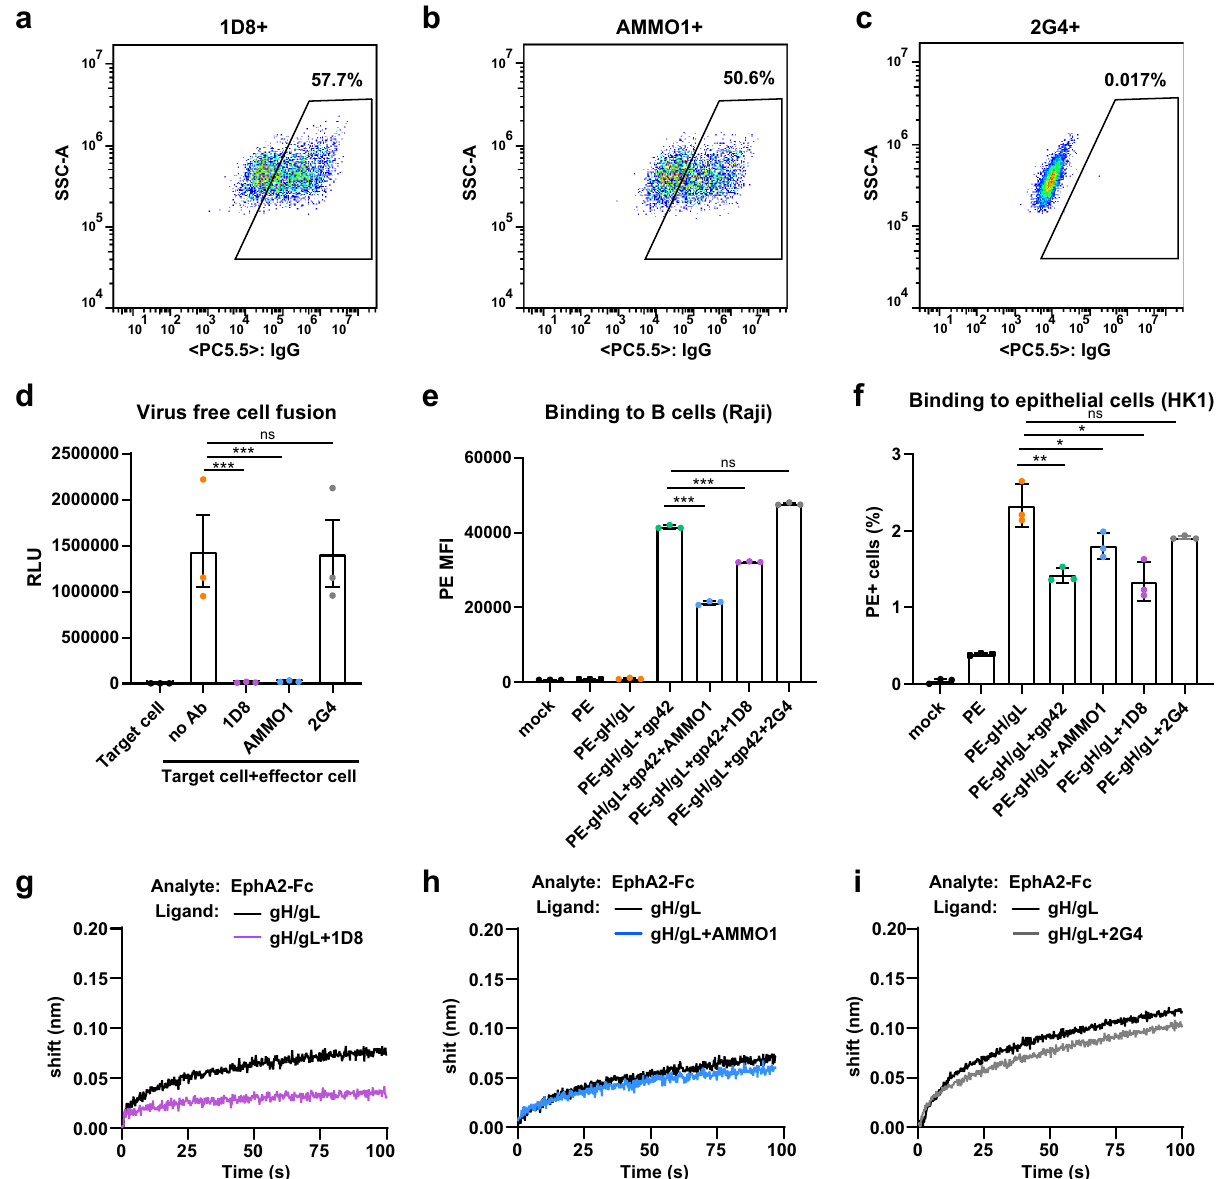
Fig. 5 1D8 interferes with cell fusion and binding. Quality control of gH/gL expression on the surface of CHO-K1 cells by staining with 1D8 ( a ), positive control AMMO1 ( b ), and negative control 2G4 ( c ) before proceeded to the fusion experiment shown in ( d ). d Marked reduction in cell-cell fusion in the presence of 1D8, the positive control AMMMO1, but not the negative control 2G4. Marked reduction in gH/gL binding to Raji B cell ( e ) and HK1 epithelial cell ( f ) in the presence of 1D8, the positive control AMMO1, but not the negative control 2G4. Binding of EphA1-Fc to gH/gL was reduced by 1D8 ( g ), but not by AMMO1 ( h ) or 2G4 ( i ) measured by BLI. All data are presented as mean ± SEM from three replicates. * p < 0.05; ** p < 0.01; *** p < 0.001; ns, no signi fi cant; two-tailed unpaired Student ’ s t test. d *** p < 0.0001; ( e ) *** p < 0.0001; ( f ) gp42 ** p = 0.0057, AMMO1 * p = 0.0478, 1D8 * p = 0.010. SSC-A, side-scatter area; PC5.5, PerCP-Cy5.5; RLU, relative light unit; SA-PE, streptavidin-phycoerythrin; MFI, mean fl uorescence intensity. Source data are provided as a Source Data with the target HEK293 cells. The inhibitory activity was mea- EBV infection. sured 24 h afterwards via the luciferase activity in the cell lysates, which only became detectable when fusion occurred. As shown in Fig. 5a – c, the effector CHO-K1 cells expressed good levels of gH/ gL as measured by fl ow cytometry. In the presence of 1D8 or AMMO1, the fusion activity was barely measurable and similar to the background where only the effector cells were present (Fig. 5d). By contrast, incubation with the negative controls 2G4 or PBS resulted in high levels of luciferase activity beyond one million relative light unit (RLU). In addition, we tested the ability of 1D8 to interfere with the binding of fl uorescently labeled or relevant controls at 37 °C for 1 h before mixing at a 1:1 ratio